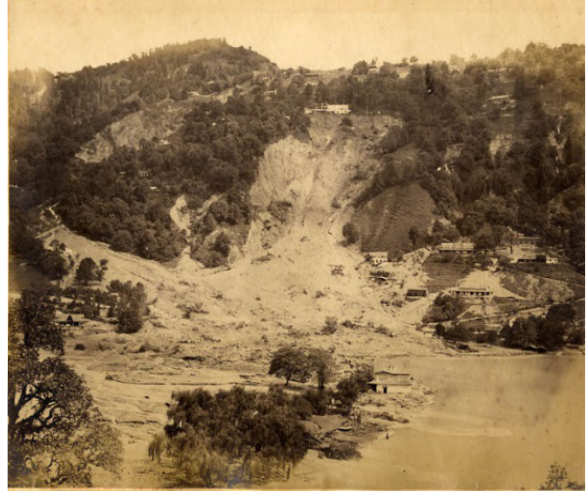
Fi gure 3: Historic photographs of the 1880 Nainital